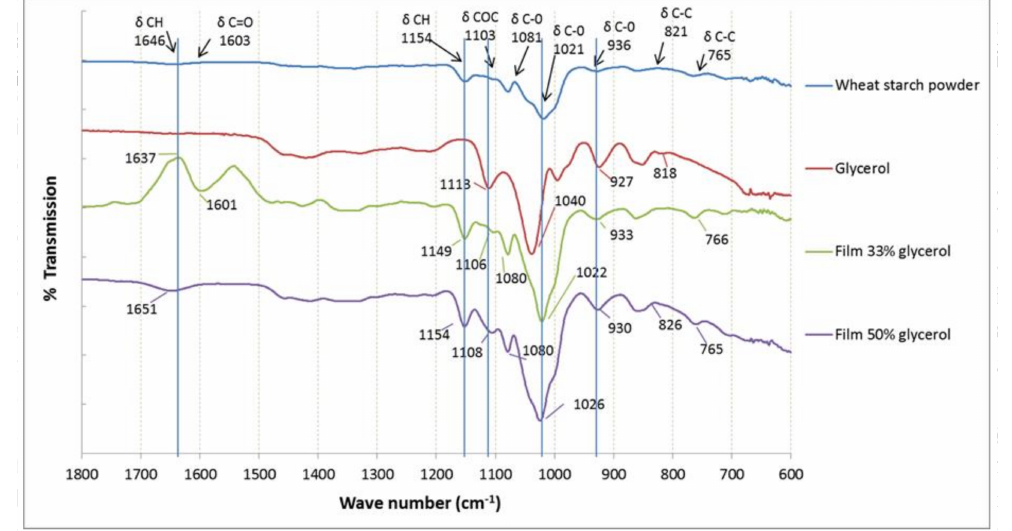
Figure 2. Fourier Transform Infrared (FTIR) spectra for wheat starch powder, pure glycerol, starch films containing 33% of glycerol, starch films containing 50% of glycerol. The blue vertical lines correspond to shifted